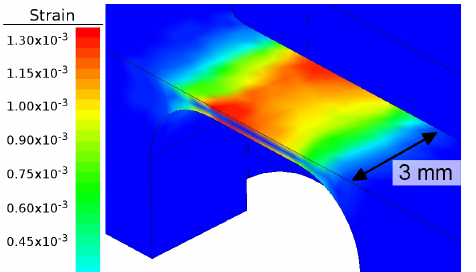
Figure 3. Deformation element as CAD model, utilized with RSGs in the areas of maximum strain. Figure 4. FE analysis of a single elastic deflection area of the de- formation element.